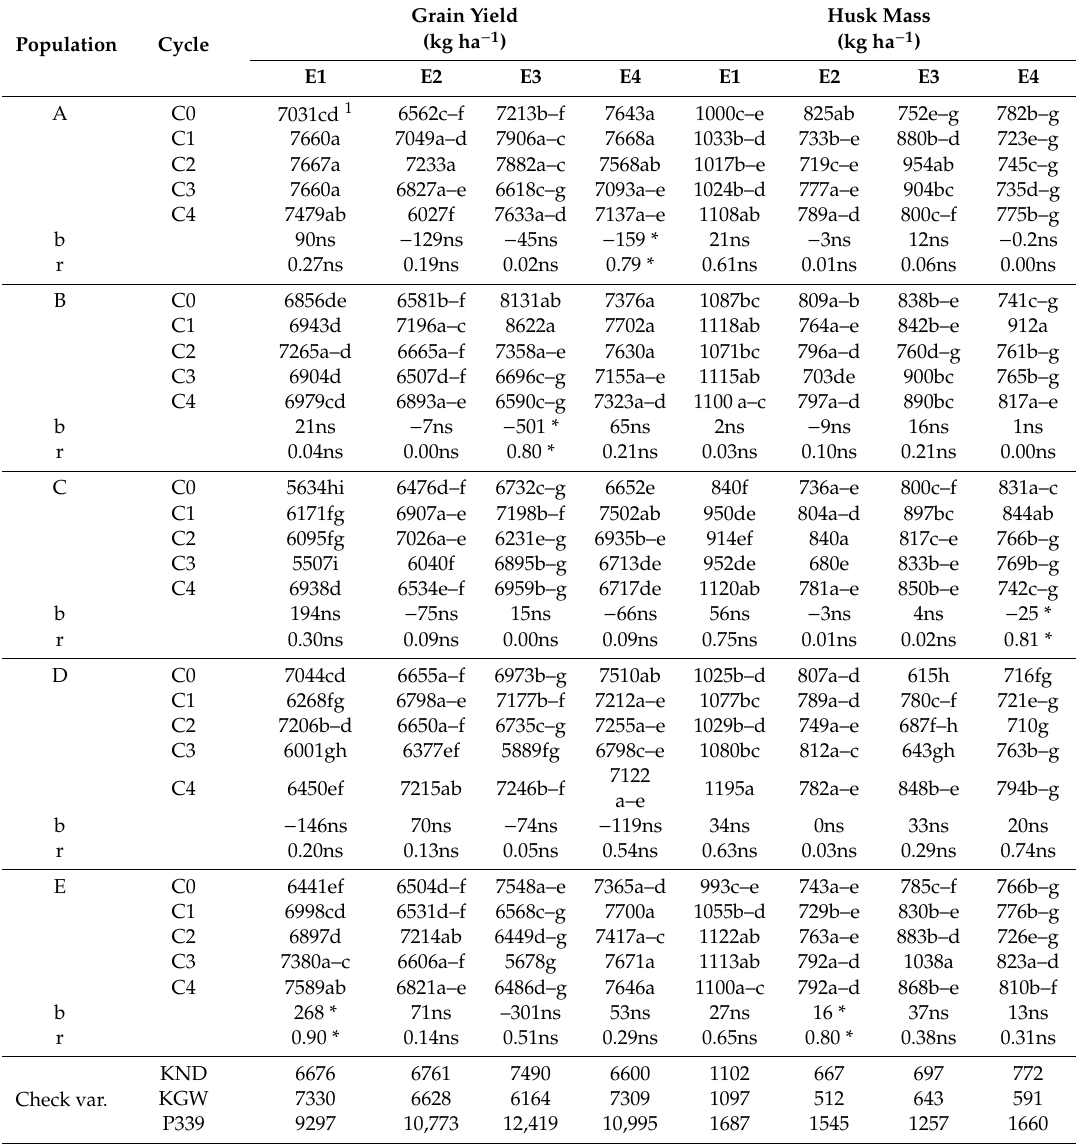
Table A1. Means for grain yield and husk mass of (A to E) five populations and (C0 to C4) five cycles evaluated in four environments.